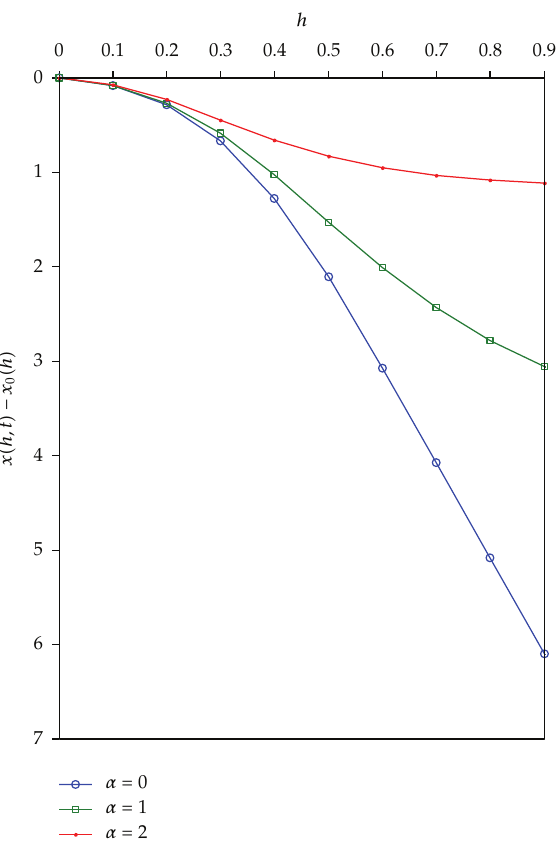
Figure 7: The e ff ect of porous medium parameter α 2 on the drainage rate for S 1 (cid:8) 2, S 2 (cid:8) 1, and μ 1 (cid:8) 10.